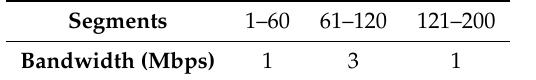
Figure 2. An example experiment of how a client reacts to the changes of fair share. Table 2. Bandwidth allocated to the client at specific periods in the streaming